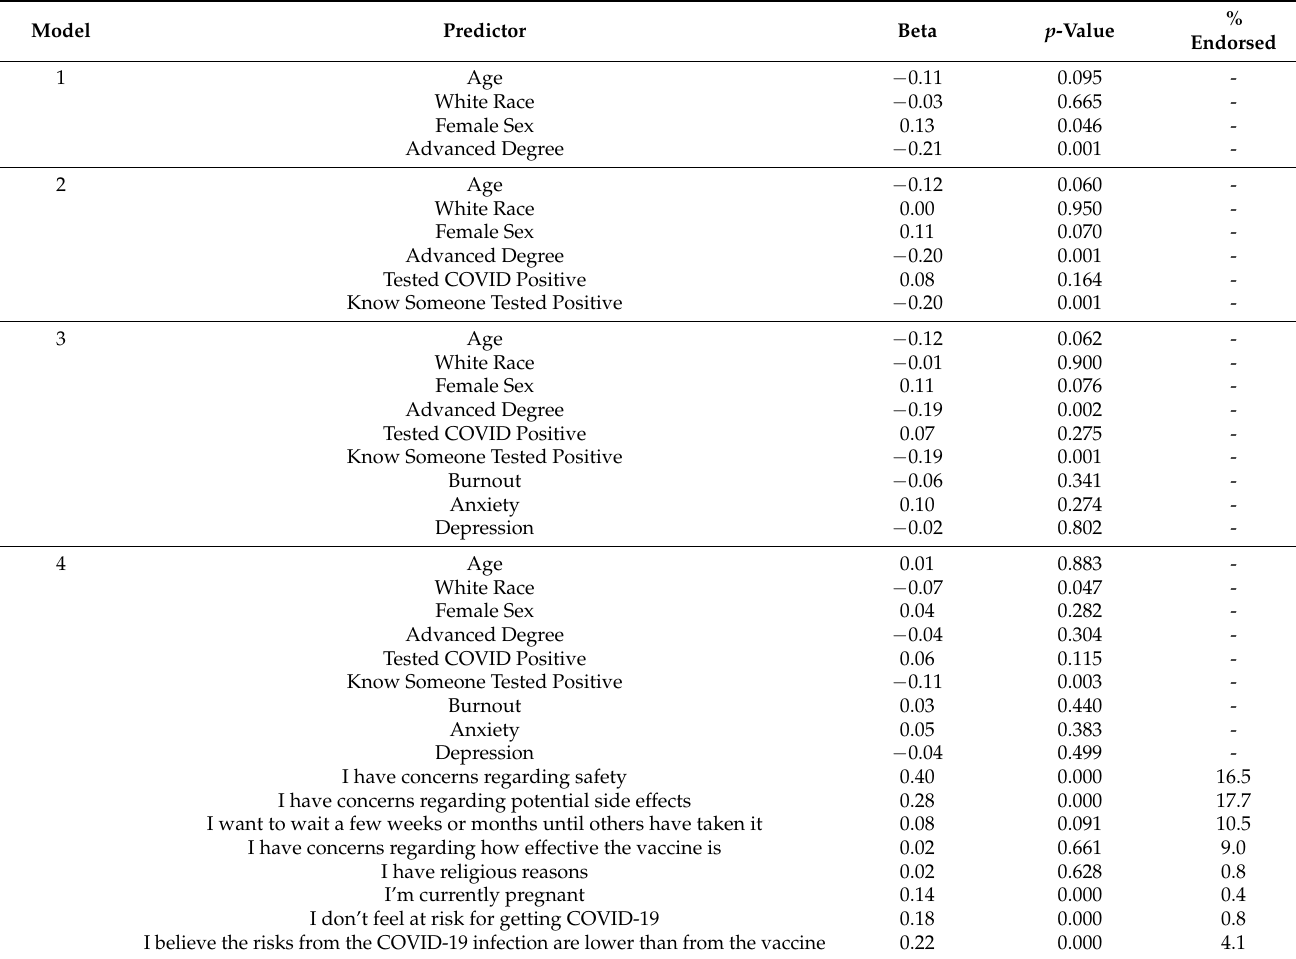
Table 2. Regression Results and Percentages of Participants Reporting Vaccine